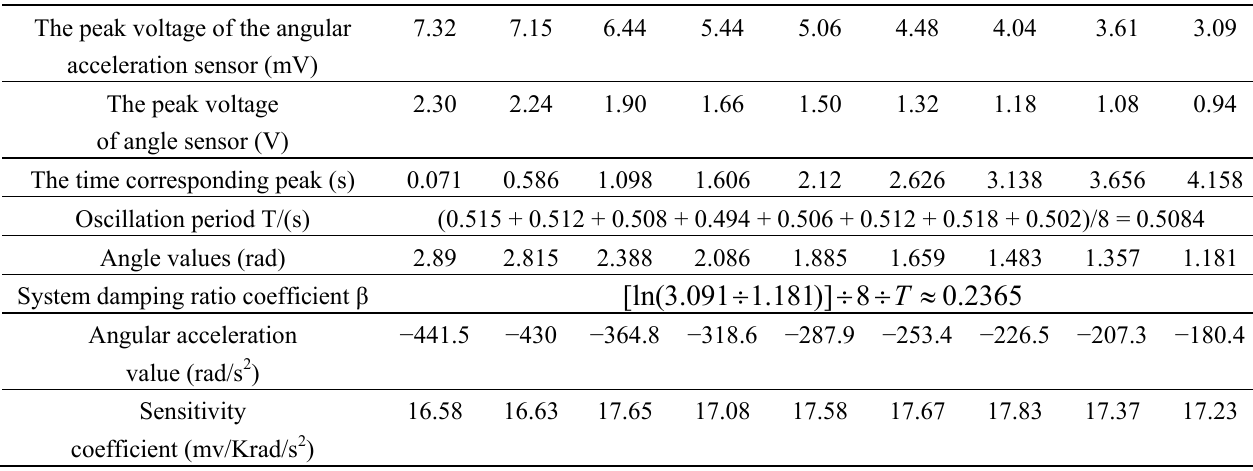
Table 1. Experimental calibration